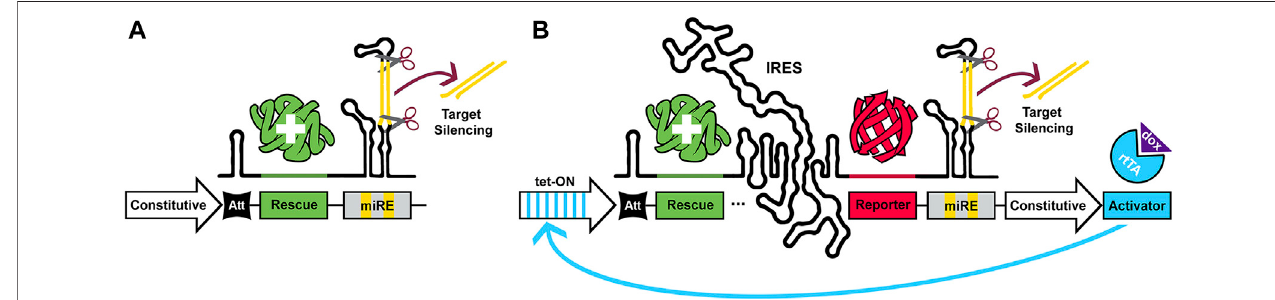
FIGURE1| Single-transgeneconstructs forgenesilencingandphysiologicallymatchedreplacement. Schematics illustrating twopossiblecon fi gurationsofpKDR constructs. (A) Represents the minimal, constitutive construct without fl uorescent reporter, which consists of a constitutive promoter, an attenuator (Att), a rescue sequence and a miRNA-adapted shRNA (miRE). (B) Represents the inducible variant with IRES and reporter inserted between the rescue sequence and the miRE sequence. A single-transgene approach to gene replacement delivers shRNA to silence endogenous expression, while allowing the system to be driven interchangeably by either constitutive and/or inducible promoters and offering control over translation level with choice of attenuator (Att)